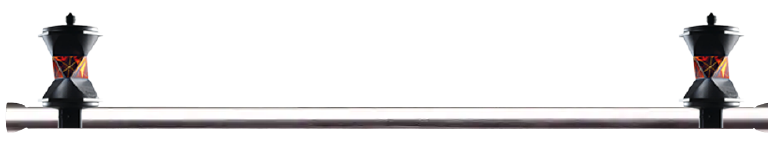
Figure 3. Fixed-length